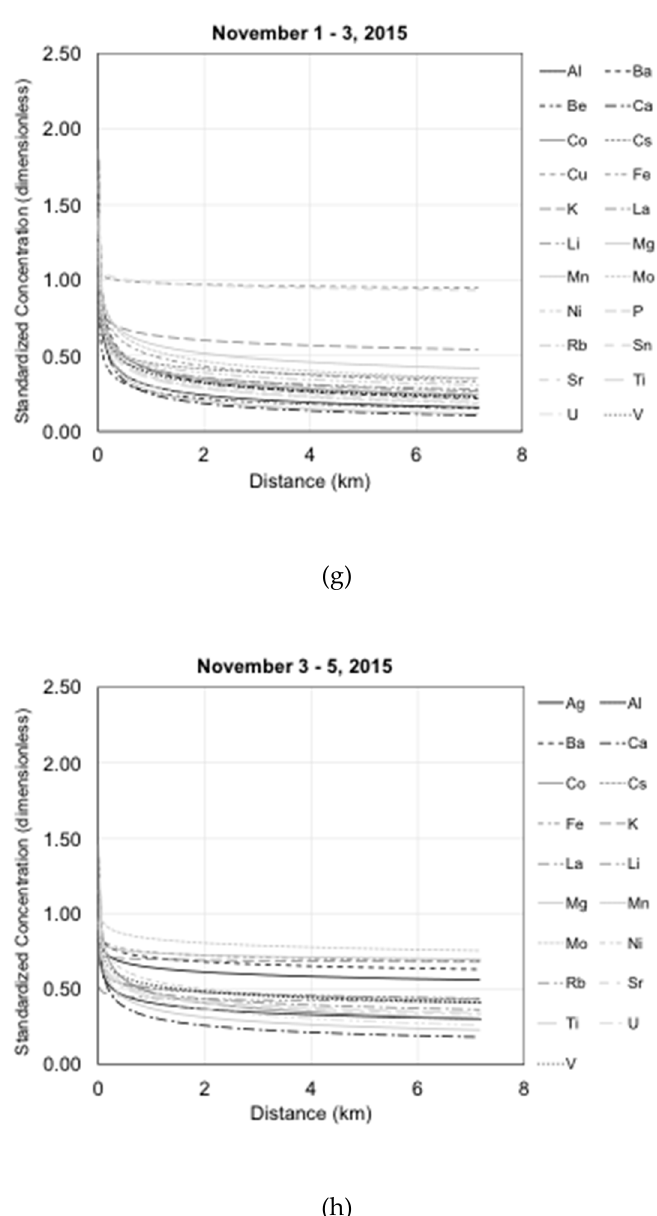
Figure 1. ( a )–( d ) Standardized concentration trends distinguishing which elements increase with distance (exclusion criteria 2); ( e )–( h ) standardized concentration trends distinguishing consistent diminution of concentration with distance (exclusion criteria 3).